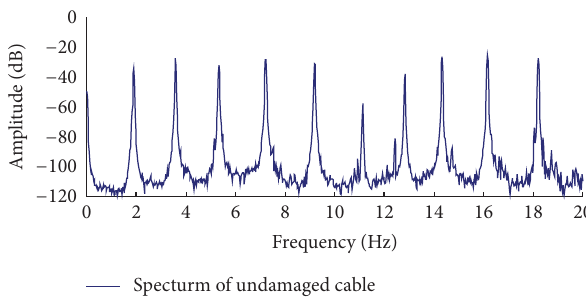
Figure 9: Spectral lines of the intact